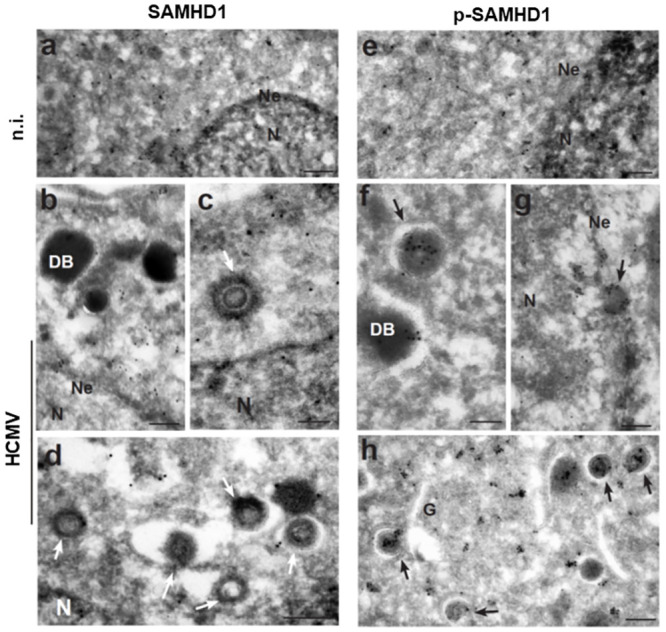
pT592-SAMHD1 associates with viral particles and dense bodies.HFFs, not infected (n.i.) or infected with AD169, were processed at 3 dpi for Cryo-IEM analysis and immunolabeled using primary specific antibodies against SAMHD1 (a-d) or pT592-SAMHD1 (e-h). One representative experiment out of seven different immune gold-labeling experiments is shown. Sparse labeling of SAMHD1 and pT592-SAMHD1 was detected in uninfected cells in the nucleus and in the cytoplasm (a, e). In infected cells, viral structures were not labeled with SAMHD1 gold (b-d; white arrows) but were gold-decorated with pT592-SAMHD1 (f-h; black arrows). N, nucleus; Ne, nuclear envelope; G, Golgi apparatus, DB, dense bodies. Bars a, b, d, e, g, h = 200nm; c, f = 100 nm.